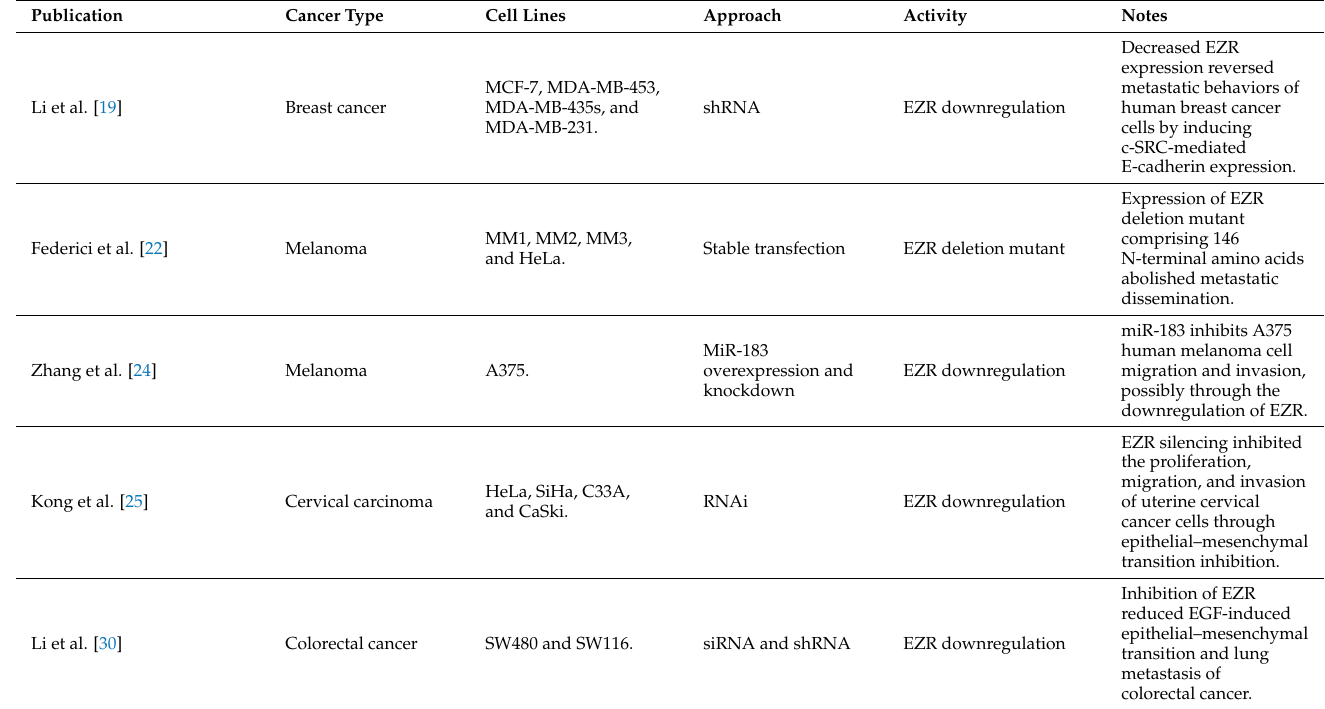
Table 2. Summary of EZR functional assays in cancer